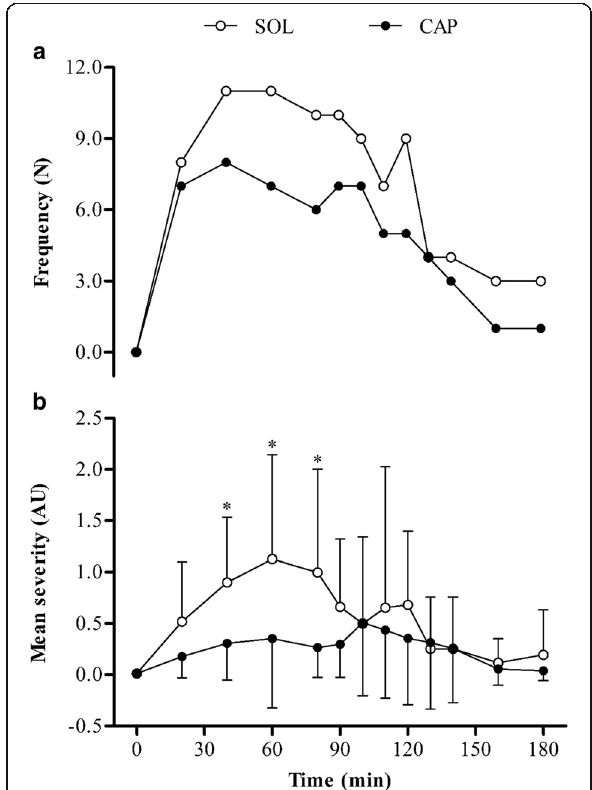
Fig. 2 Mean (± SD) blood bicarbonate concentrations. The asterisk denotes significant difference between SOL and CAP conditions ( P <